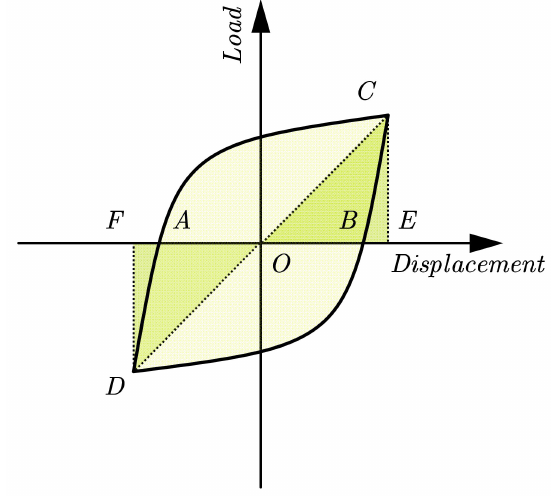
Figure 19. Typical hysteresis loop diagram.